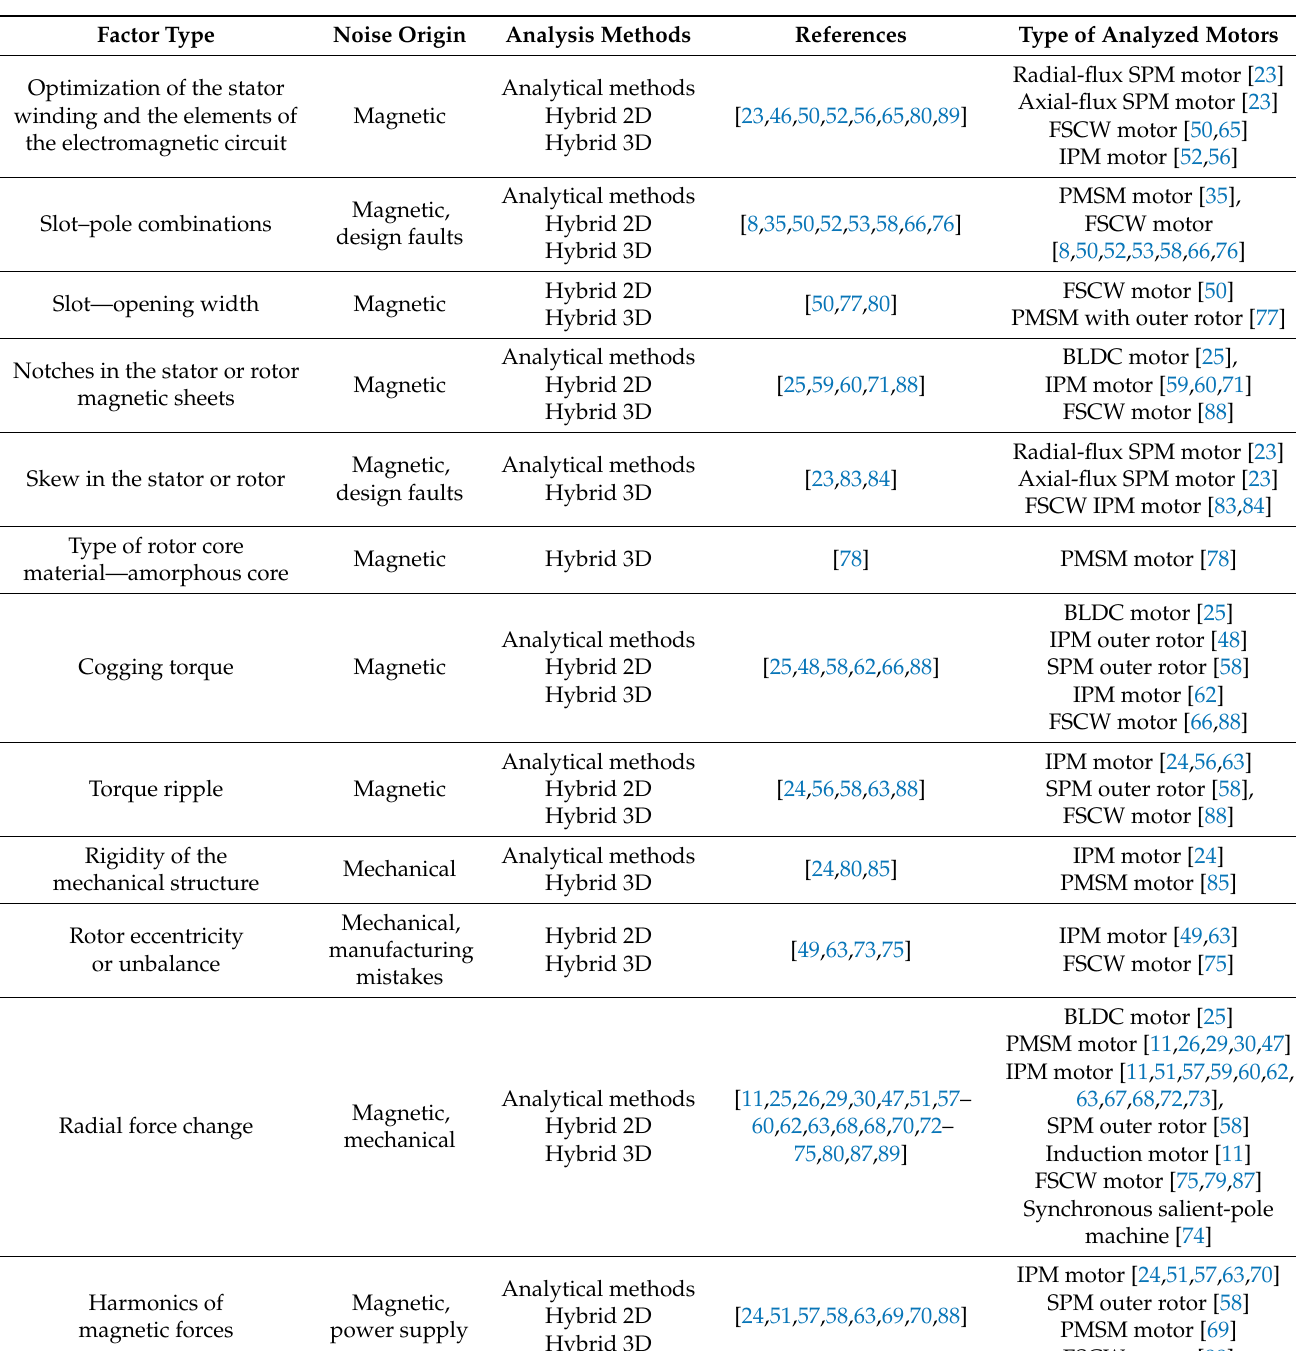
Table 2. The influence of various factors on NVH of motors for electric